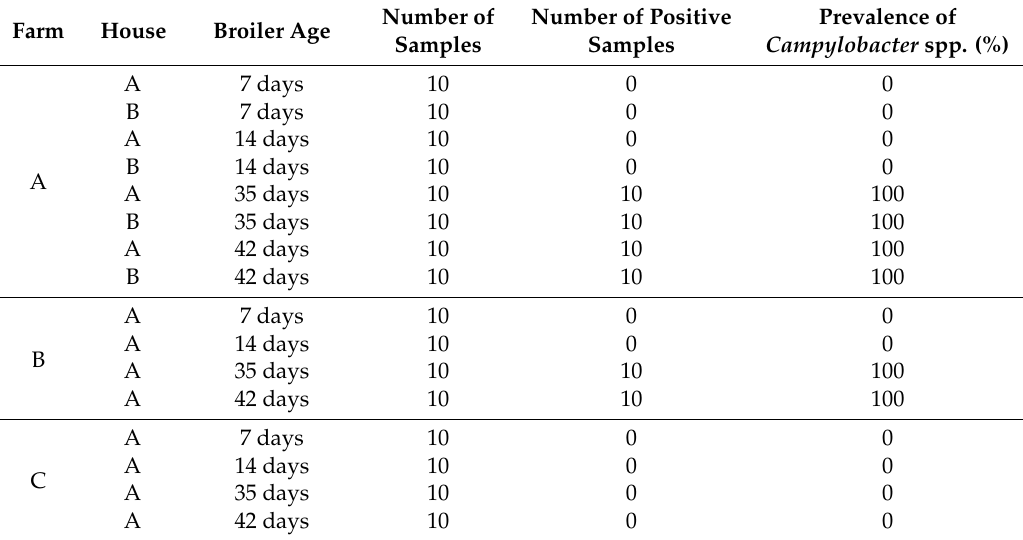
Table 1. Prevalence of Campylobacter spp. in broilers from three farms: A, B and C. Farm